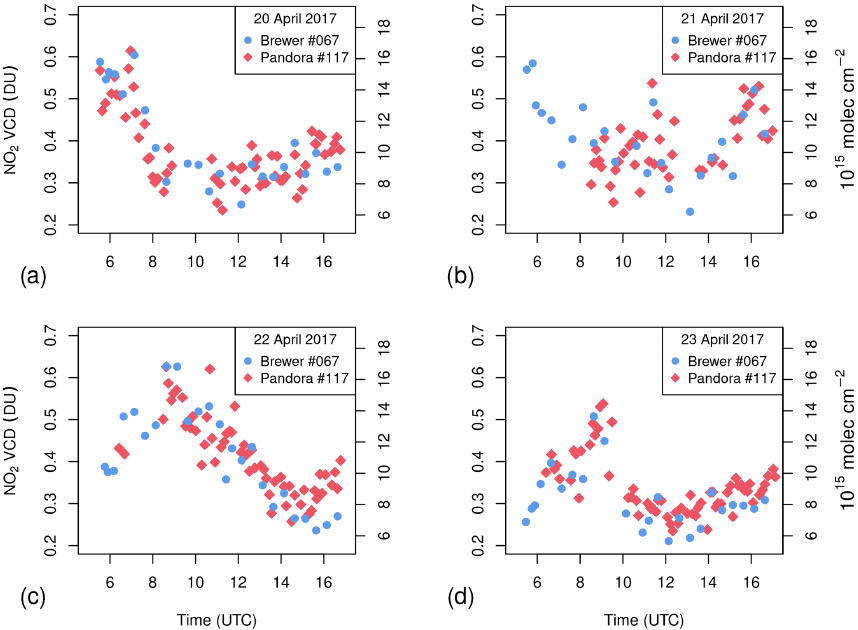
Figure 9. Independent retrievals from instantaneous measurements by Brewer #067 and Pandora #117 on four selected days (20– 23 April 2017). Notice that some Pandora data are missing on 21 April before 08:00UTC due to a power supply issue.